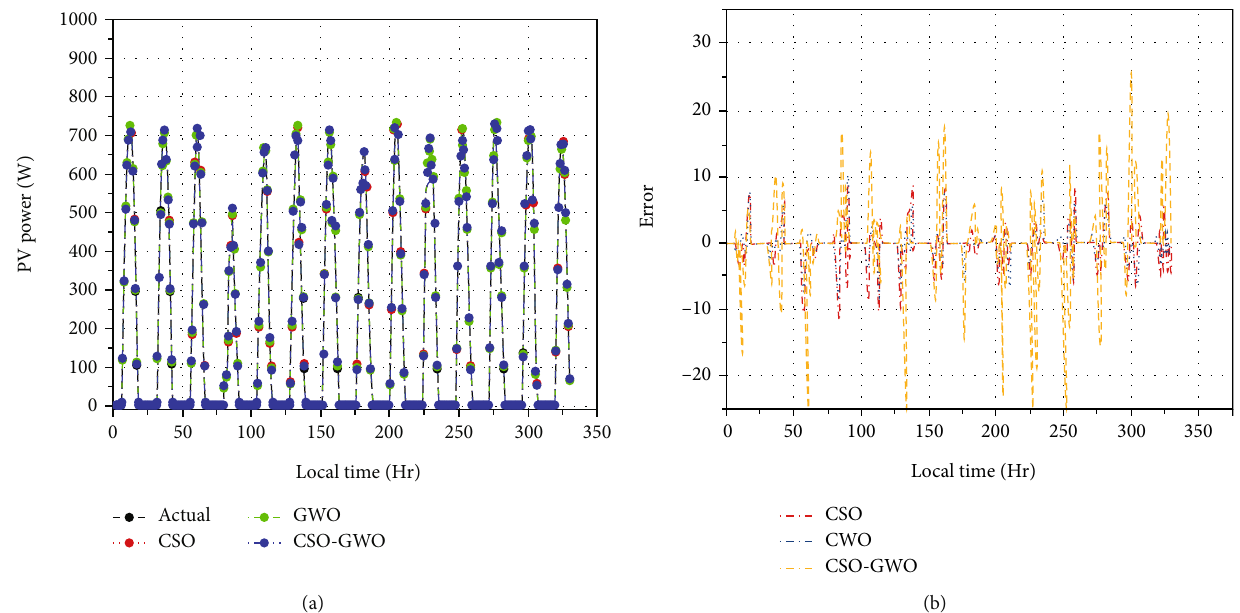
Figure 7: (a) weekly output power prediction of the PV system (b) error analysis.